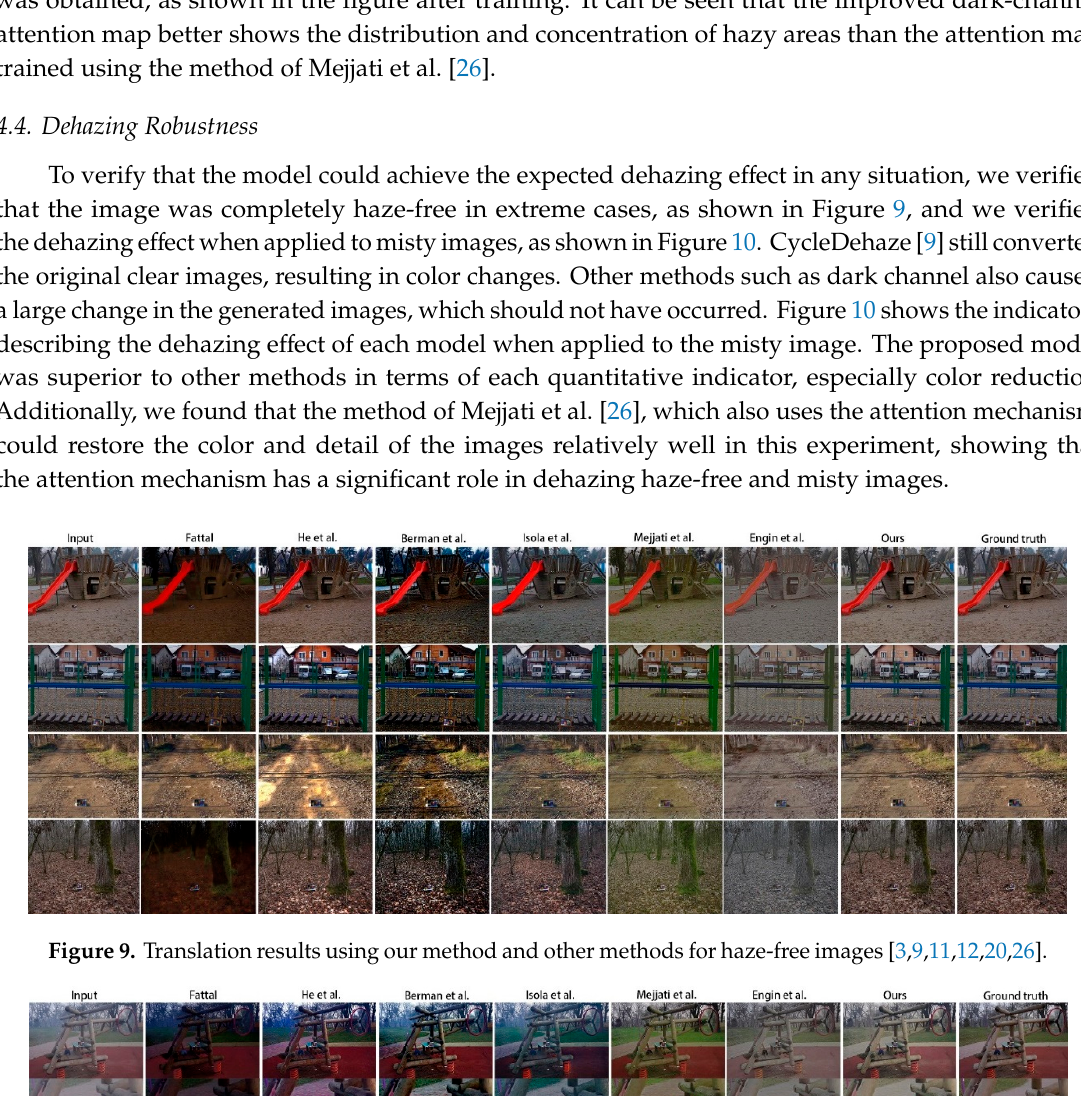
Figure 8. Results obtained with proposed attention map and that using the method of Mejjati et al. [26] through training of the network.